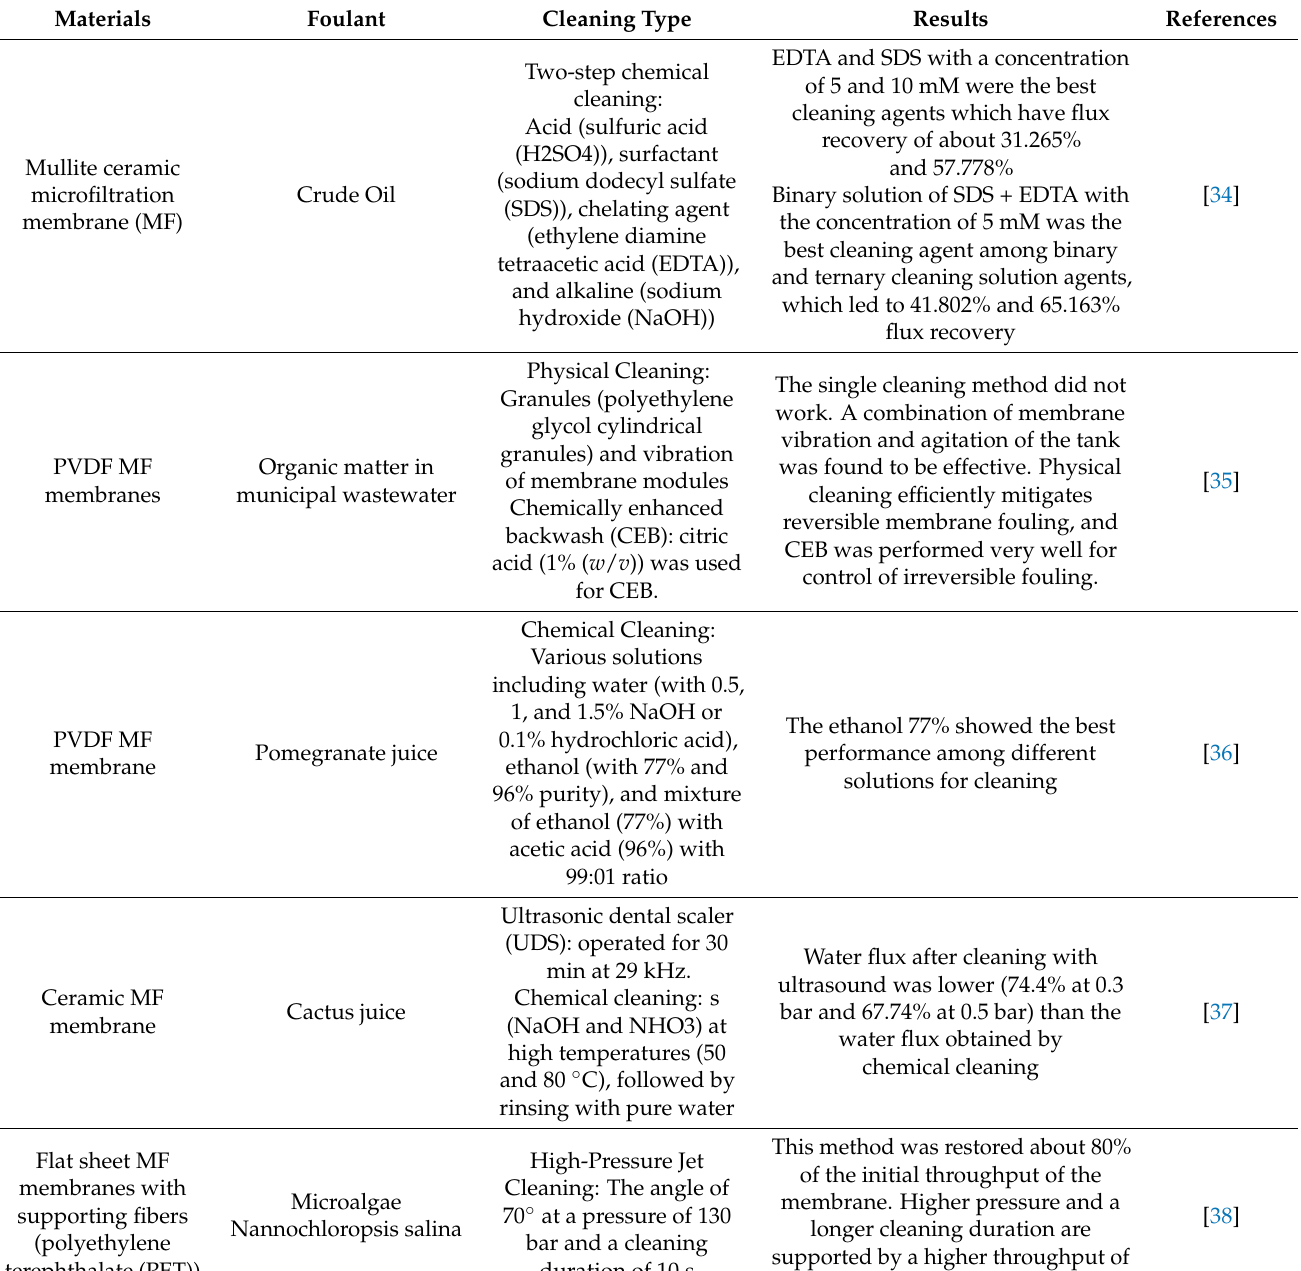
Table 3. Updated cleaning studies in microfiltration during the past 5